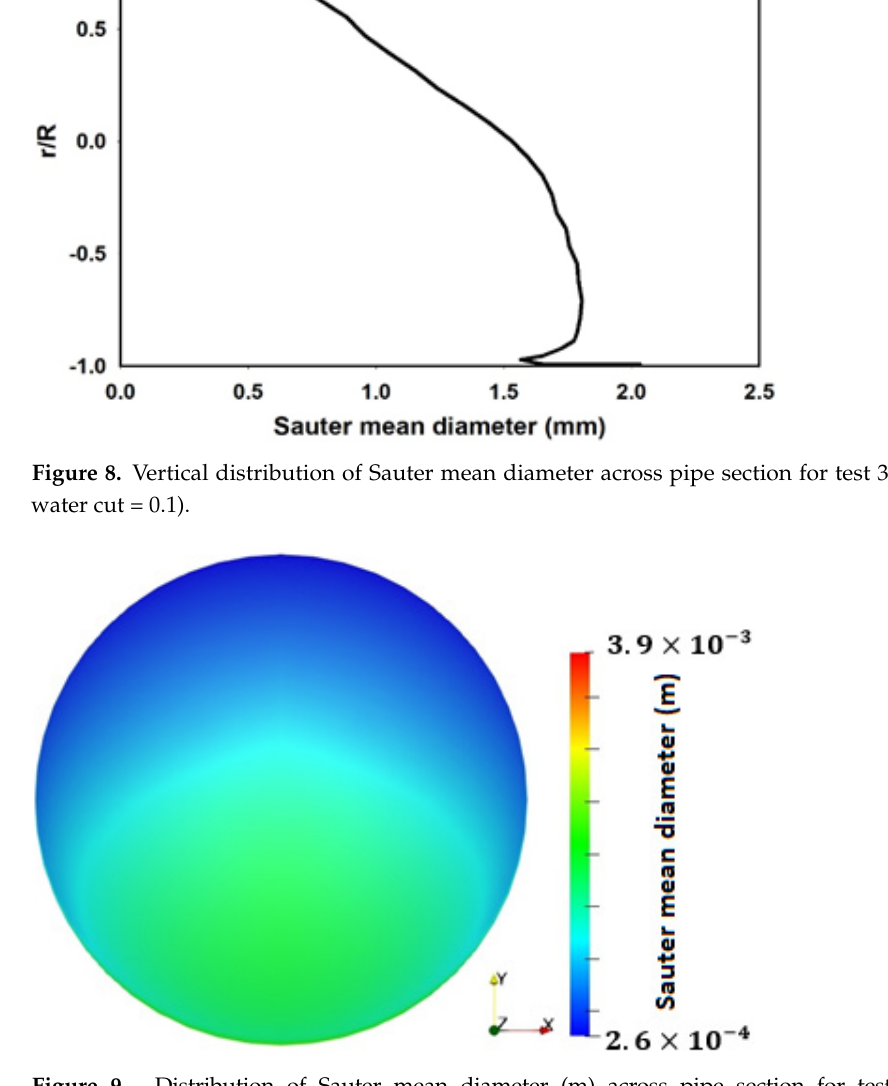
Figure 9. Distribution of Sauter mean diameter (m) across pipe section for test 3 (mixture velocity = 2 m/s, water cut = 0.1).